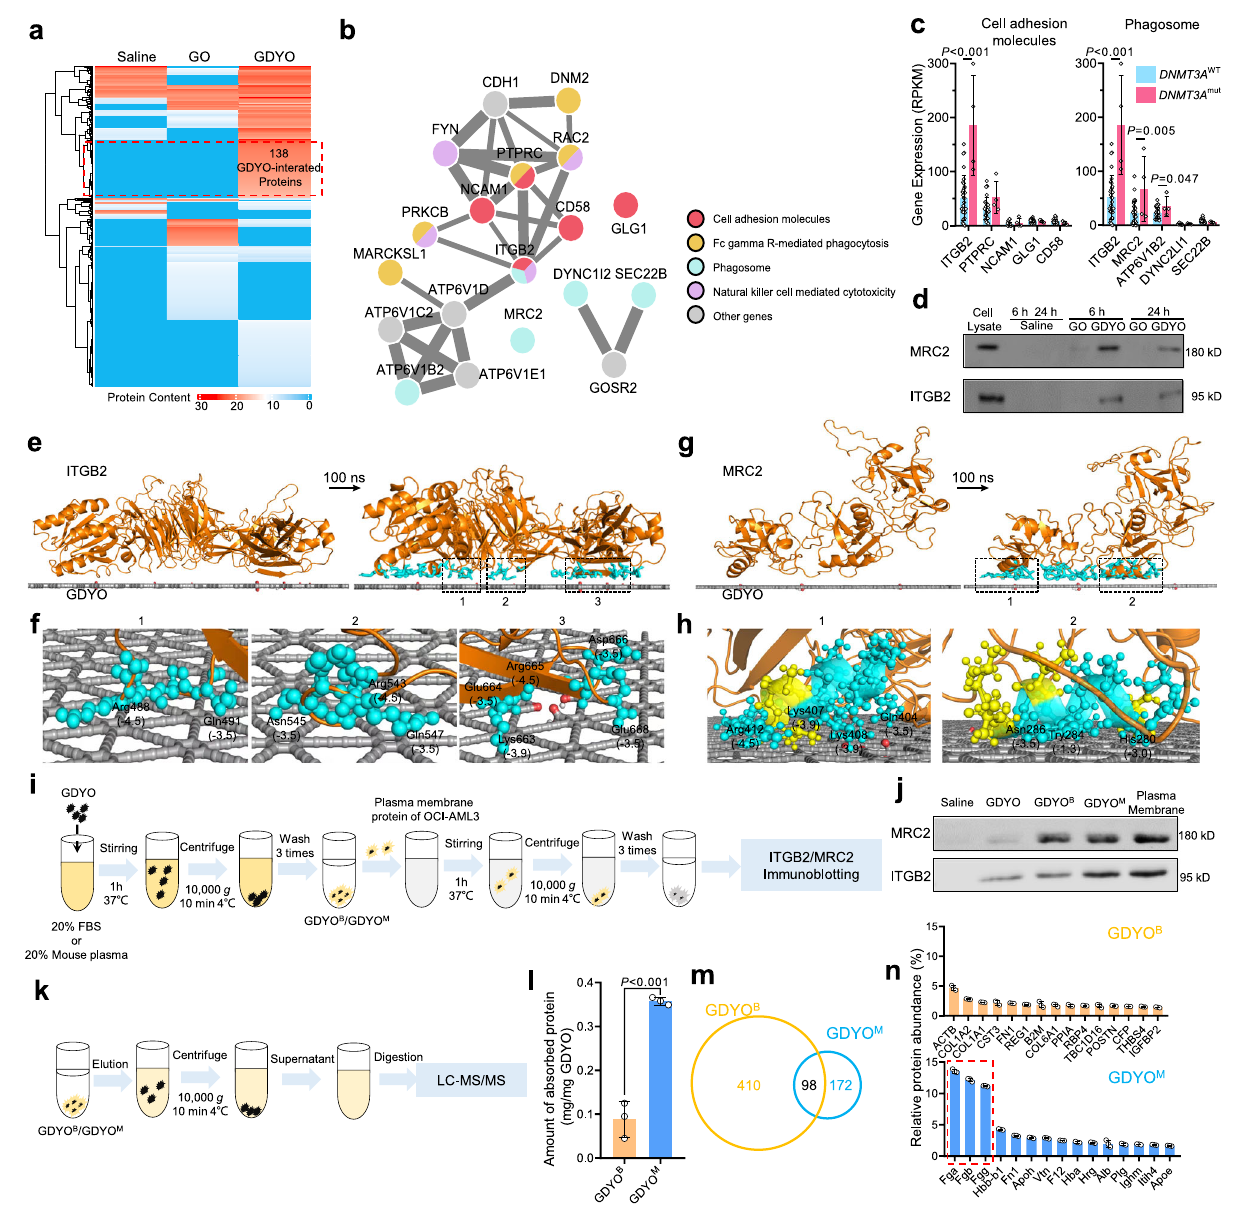
Fig. 4 | GDYO directly interacted with ITGB2 and MRC2 in DNMT3 A mutant cells. a Heatmap of GDYO-interacted proteins detected by LC-MS/MS, n =2. b Interaction network of key proteins. c Gene expression of proteins in key path- ways between DNMT3A mut and DNMT3A wt human AML cell lines from CCLE data- base. DNMT3A mut , n =4; DNMT3A wt , n =30. d Antibody-guided immunoblot veri fi